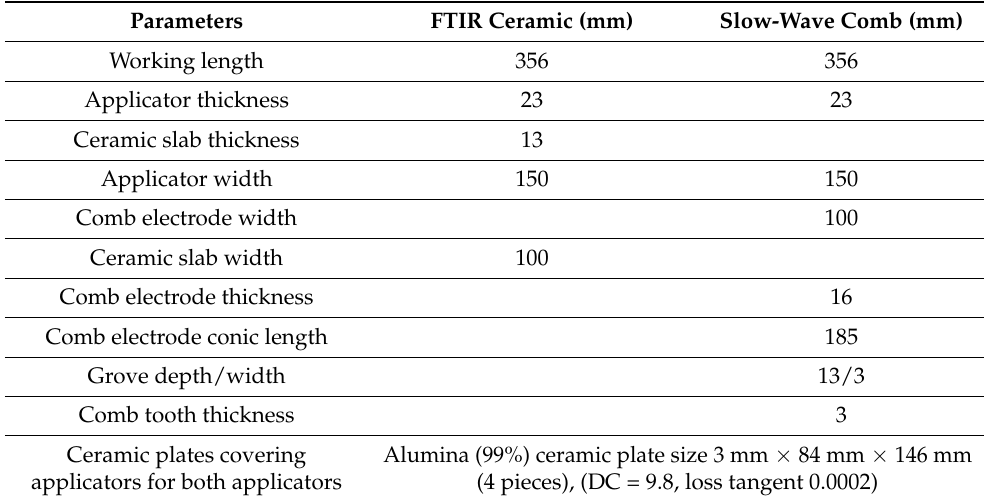
Table 1. Applicator